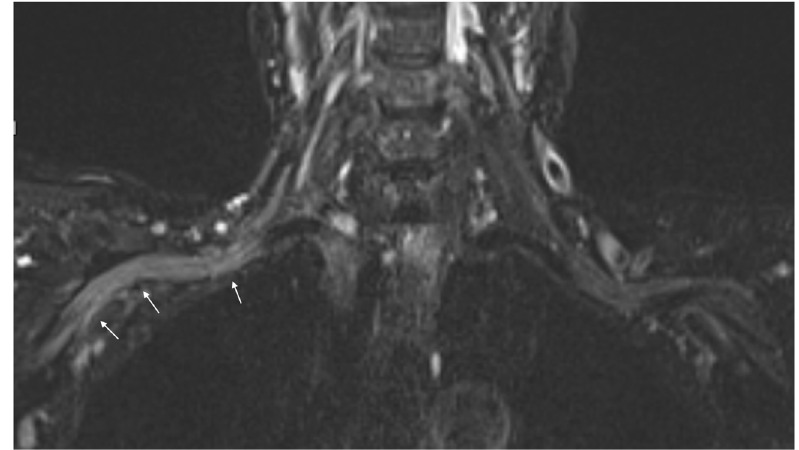
Fig. 4 Brachial plexus neuritis in a 74-year-old woman with acute distal right arm paresis. In the preceding weeks she had nausea, vomiting and weight loss, and felt increasingly forgetful and unsteady. A fluid-sensitive coronal STIR sequence showed diffusely increased signal of the nerve bundle on the right side (arrows) compared to the left side. Lumbar puncture followed, and showed cell count of 101/mm 3 as wellasa positive Bb IgGantibody index